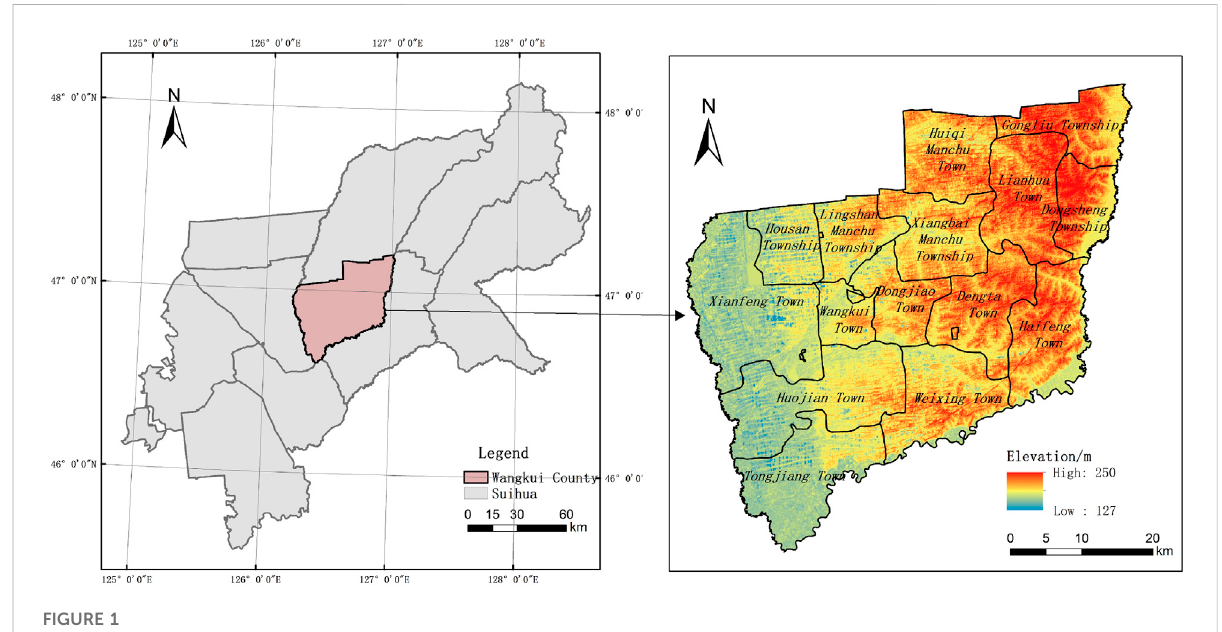
FIGURE 1 The geographical localization of the study